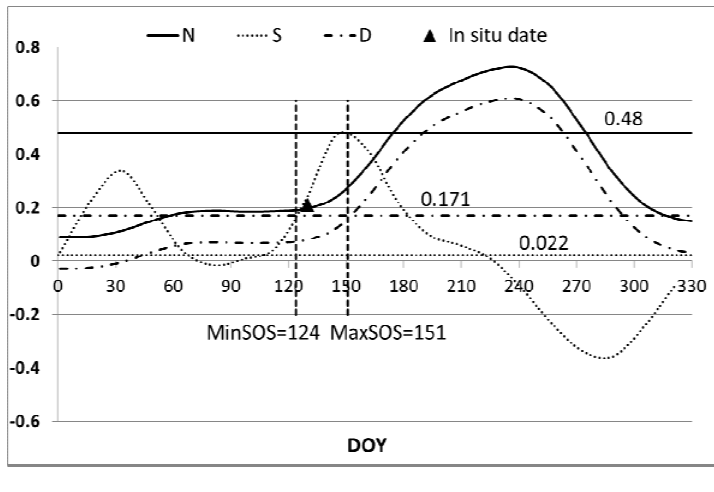
Figure 9. NDVI, slope, and difference curves for a pixel with no detectable SOS value. N = NDVI; S = Slope; D = Difference. The horizontal lines represent the detection thresholds for N, S, and D. The dotted vertical lines show the minimum (left) and maximum (right) days for the SOS. For all three thresholds, the day of the SOS corresponding to the threshold falls outside the range of SOS dates. The pixel does not provide an acceptable result and is